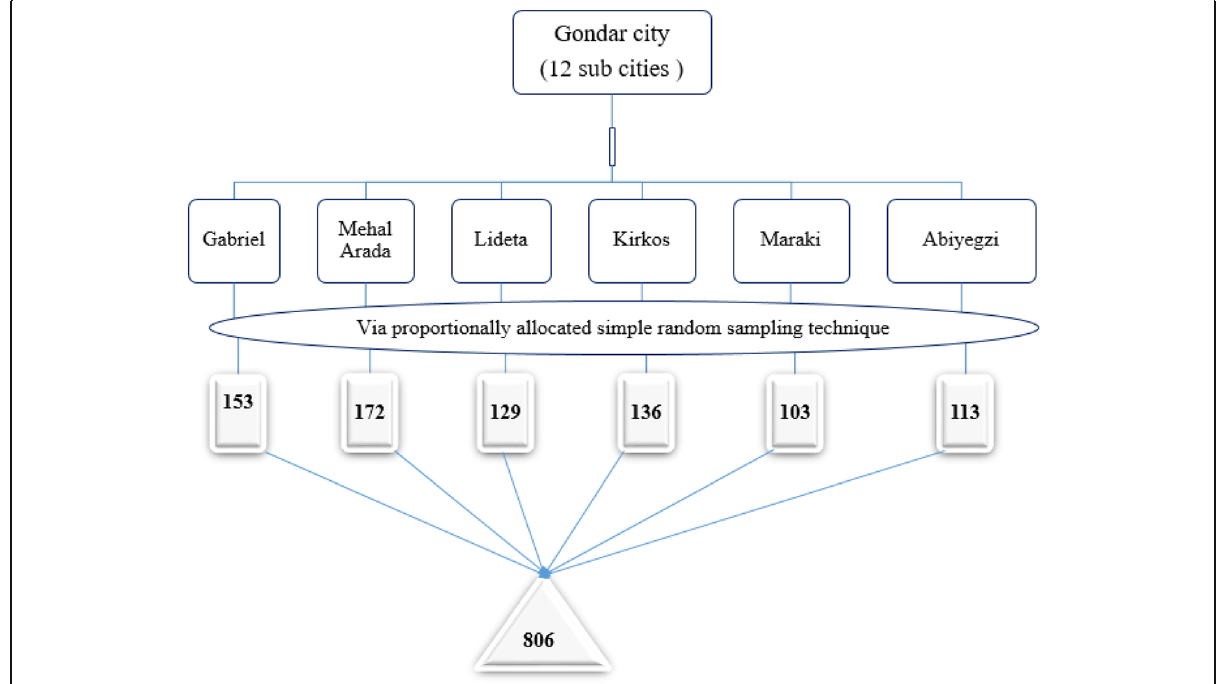
Fig. 2 A flow chart of the sampling procedures for selection of study participants in Gondar city, northwest Ethiopia